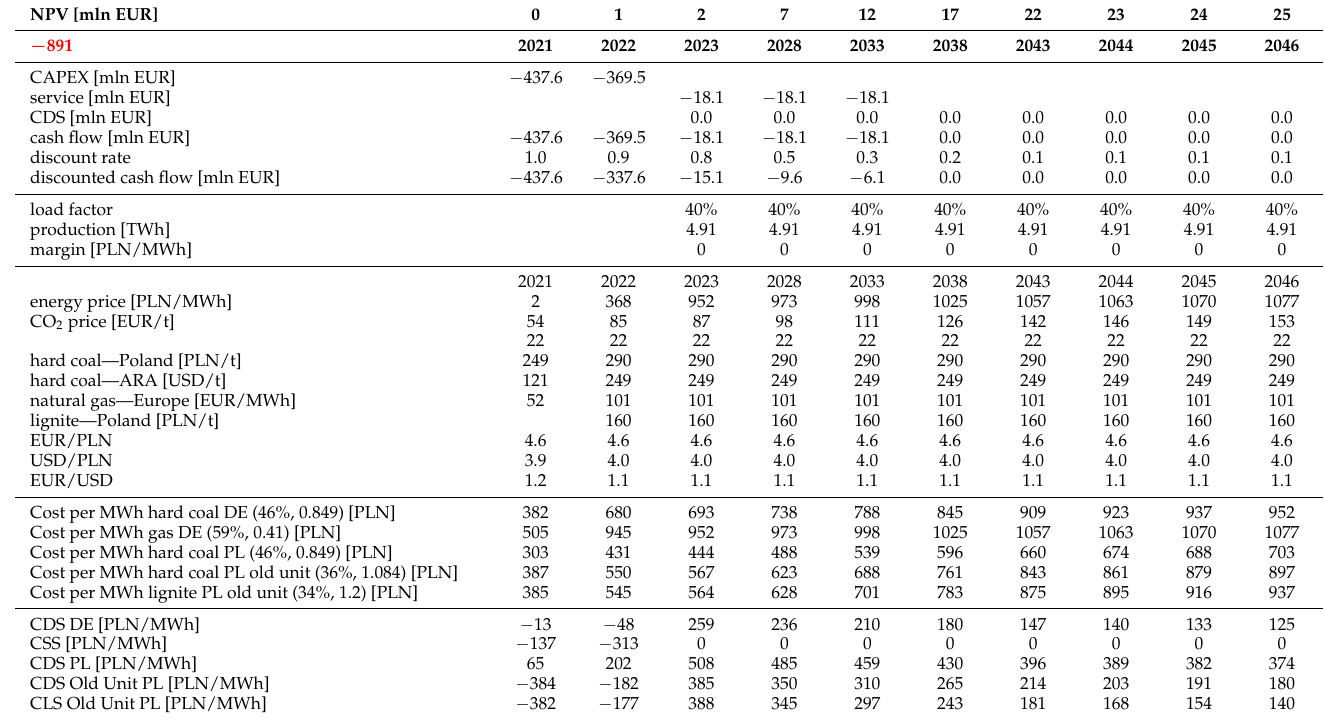
Table 2. First scenario (source: created by the authors in